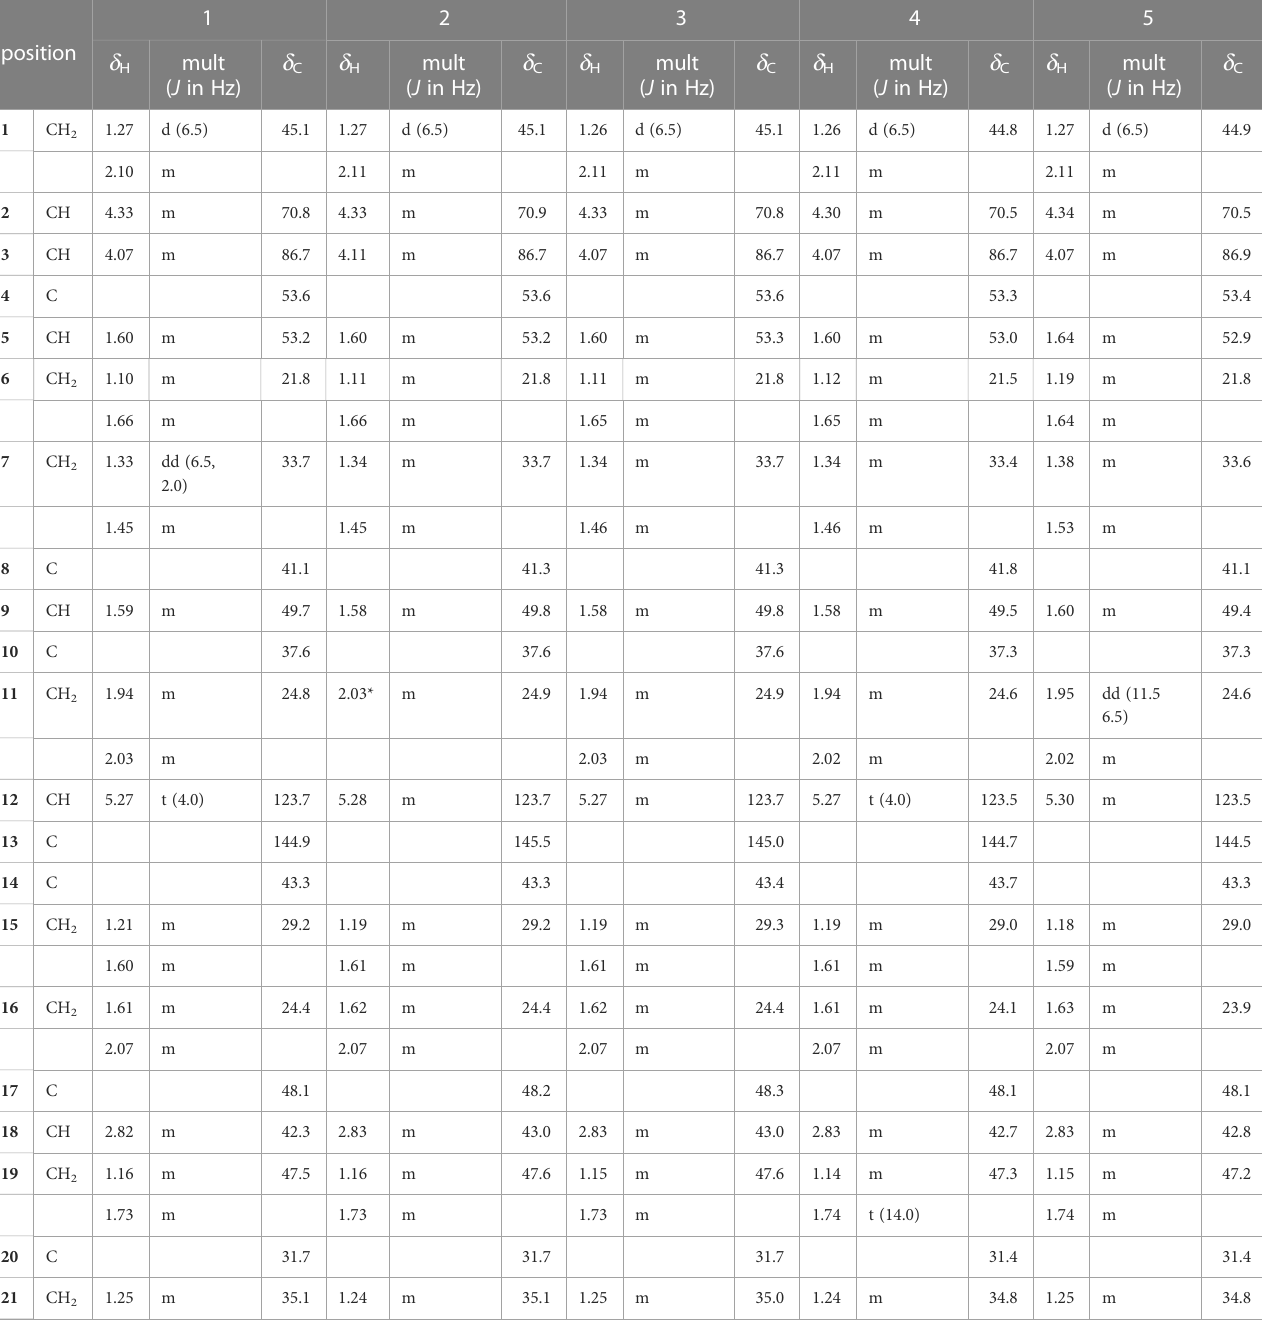
TABLE 1 1 H and 13 C NMR spectroscopic data of aglycone of pannosides A – E (1 – 5).